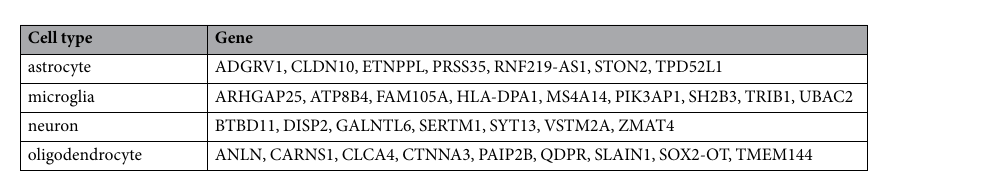
Table 2. Novel marker genes validated by